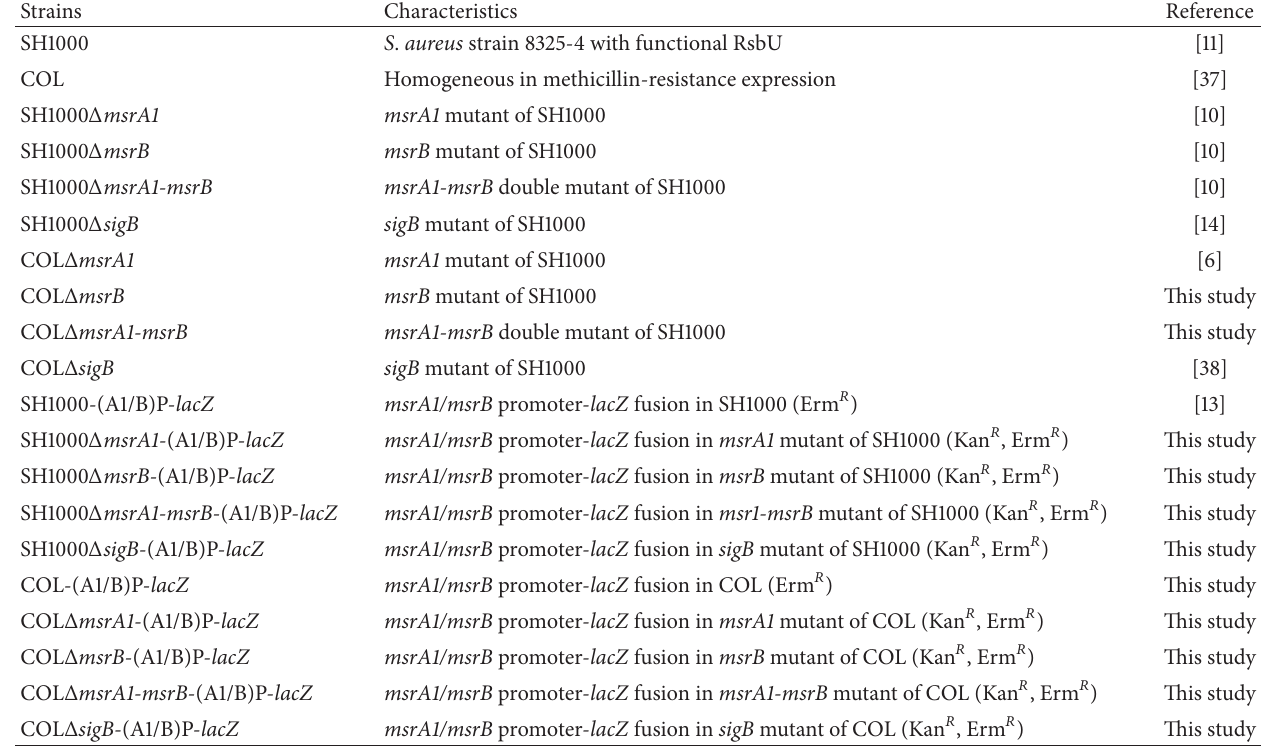
Table 1: Bacterial strains used in this study.